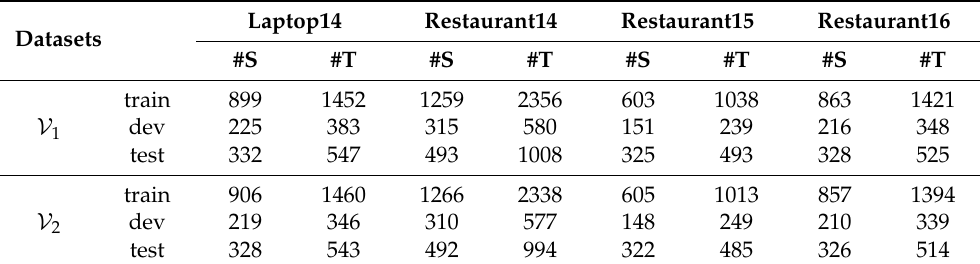
Table 2. Statistics of two groups of experiment